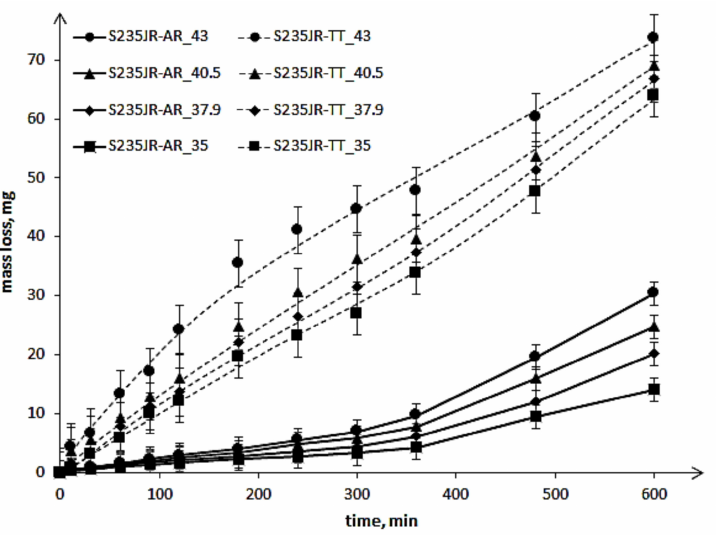
Figure 6. Cavitation erosion curves of S235JR steel in as-received state and after thermal treatment.